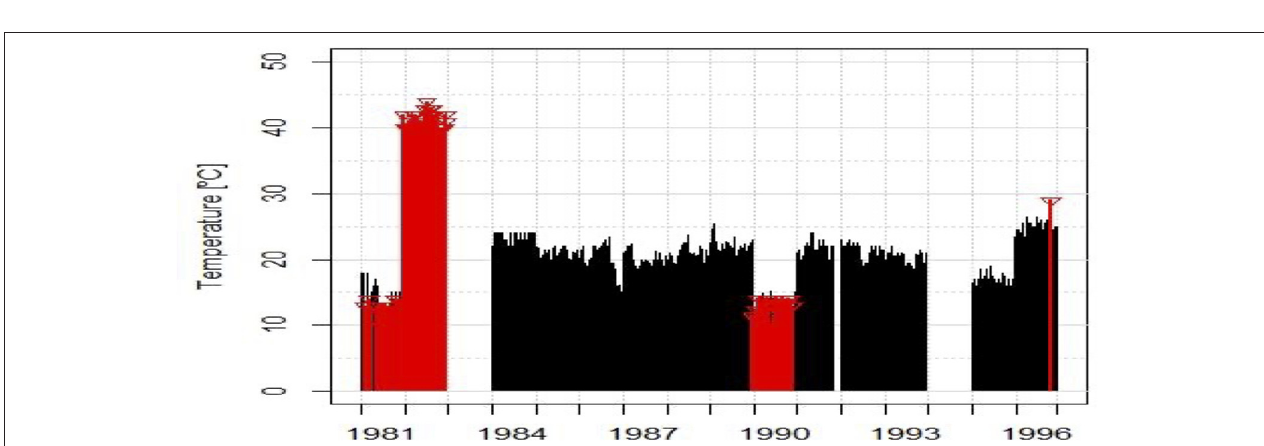
FIGURE 8 | CDT output of temporal check for minimum temperature for the month of May. The red bars show what CDT identifies as outliers (values that are too large or too small compared to what is expected for that month). The blank spaces show missing data.